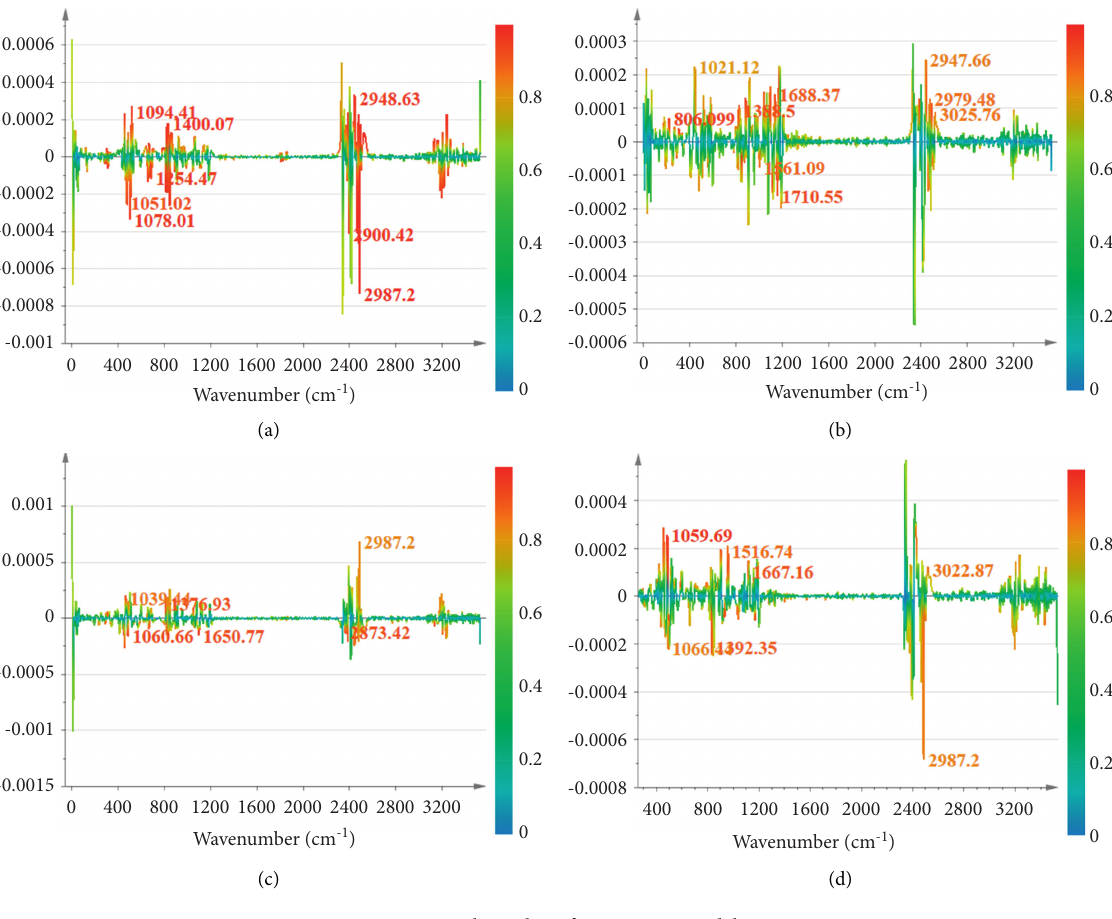
Figure 6: S-line plot of OPLS-DA